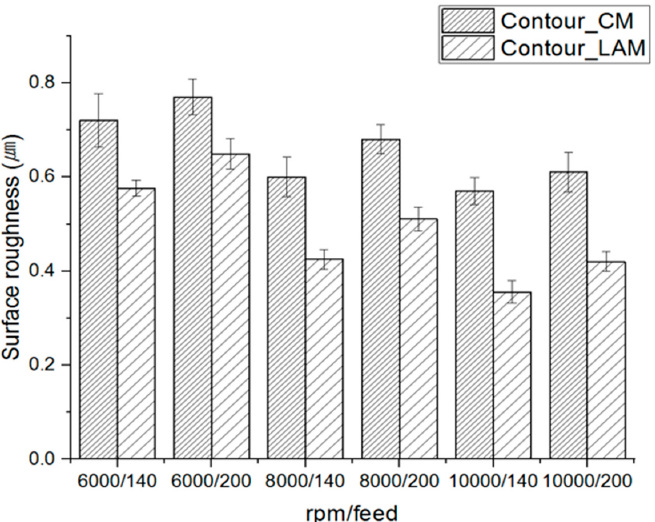
Figure 18. Surface roughness in the contour milling.